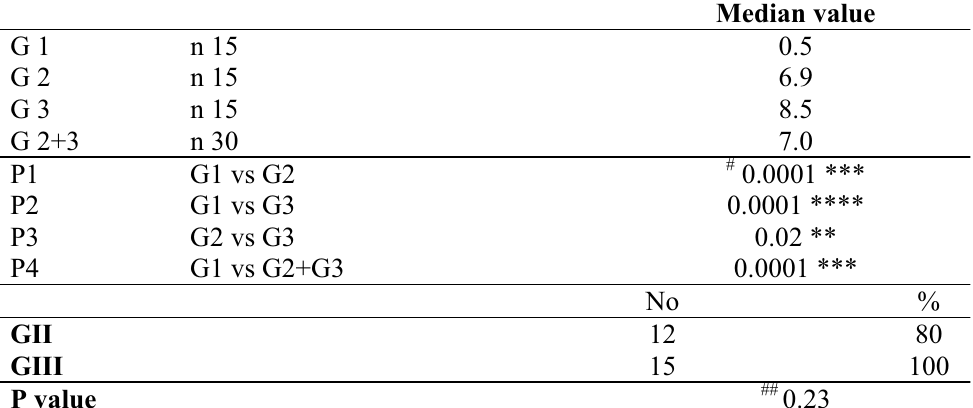
TABLE 5 - CRP median value and frequency of positive cases (cutoff level 0.5